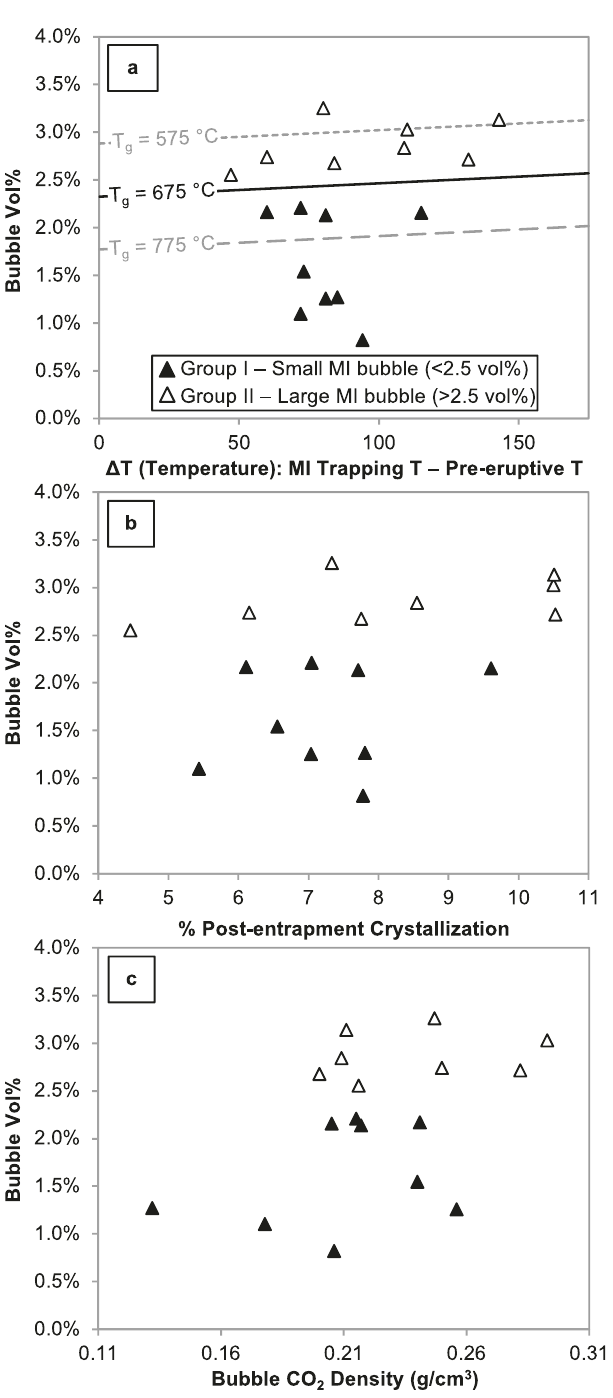
Fig. 3 Bubble vol% vs. MI properties to illustrate variable formation mechanisms for the two groups. Filled symbols are MIs with bubbles